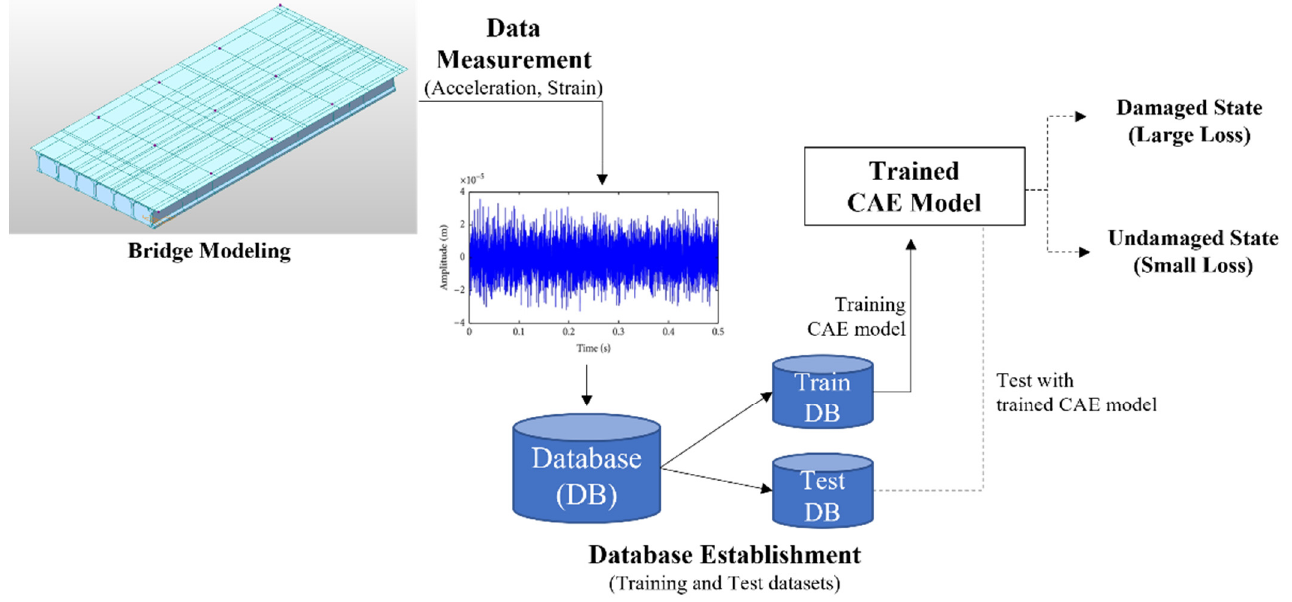
Figure 1. Data pipeline for CAE-based damage-detection framework.